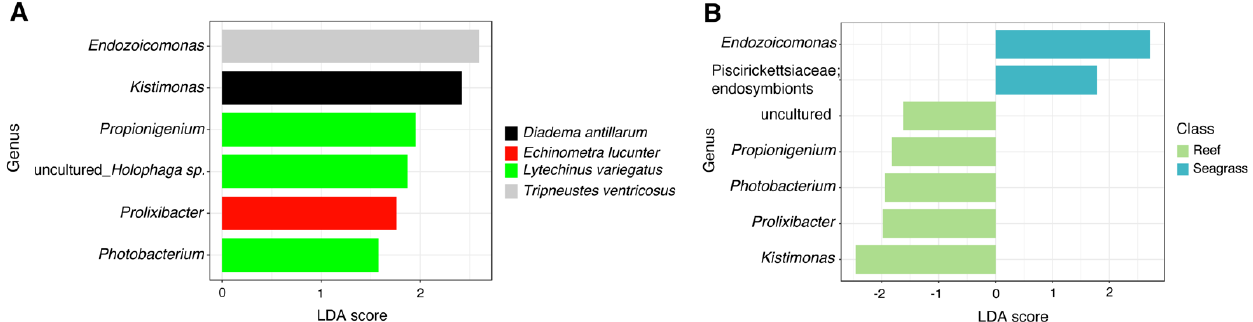
Figure 4. Differences in relative abundances of genus-level taxa between ( A ) sea urchin species and ( B ) trophic niches (reef vs. seagrass) by LEfSe analysis (Logarithmic LDA score > 2.0; alpha value < 0.05).